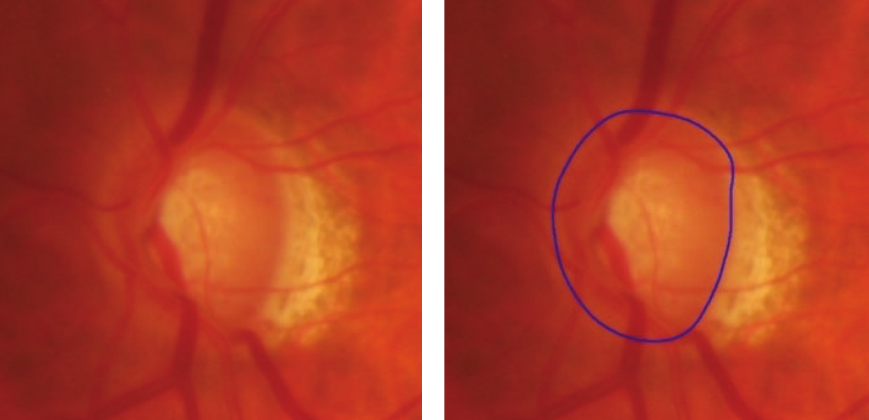
Figure 12: Balloon snake results.